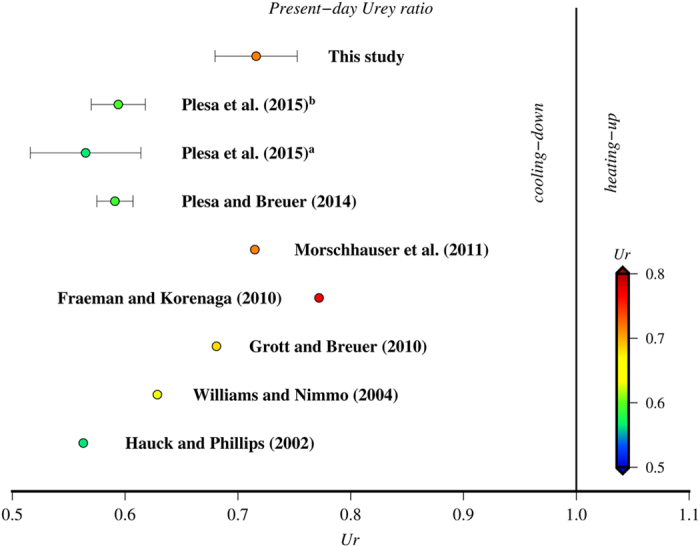
Compilation of present-day Urey ratios obtained for Mars for several convective history models compared with our results.The Urey ratio range corresponding to the present work is bounded by the results of the FNPR- and FSPR-based models, and the central dot represents the Ur value intermediate between the results of both models. Urey ratios from Plesa et al.38, where directly quoted by these authors (superscript indicate, respectively, 2D cylindrical and 3D spherical simulations). Urey ratios for the models by Hauck and Phillips45, Williams and Nimmo46, Grott and Breuer17, Fraeman and Korenaga47, and Morschhauser et al.48 were calculated from the present-day heat flow obtained by these models and the total heat production from the composition model of Wänke and Dreibus37. Ur = 1 separates the fields where the planet’s interior is cooling-down (Ur < 1) or heating-up (Ur > 1).